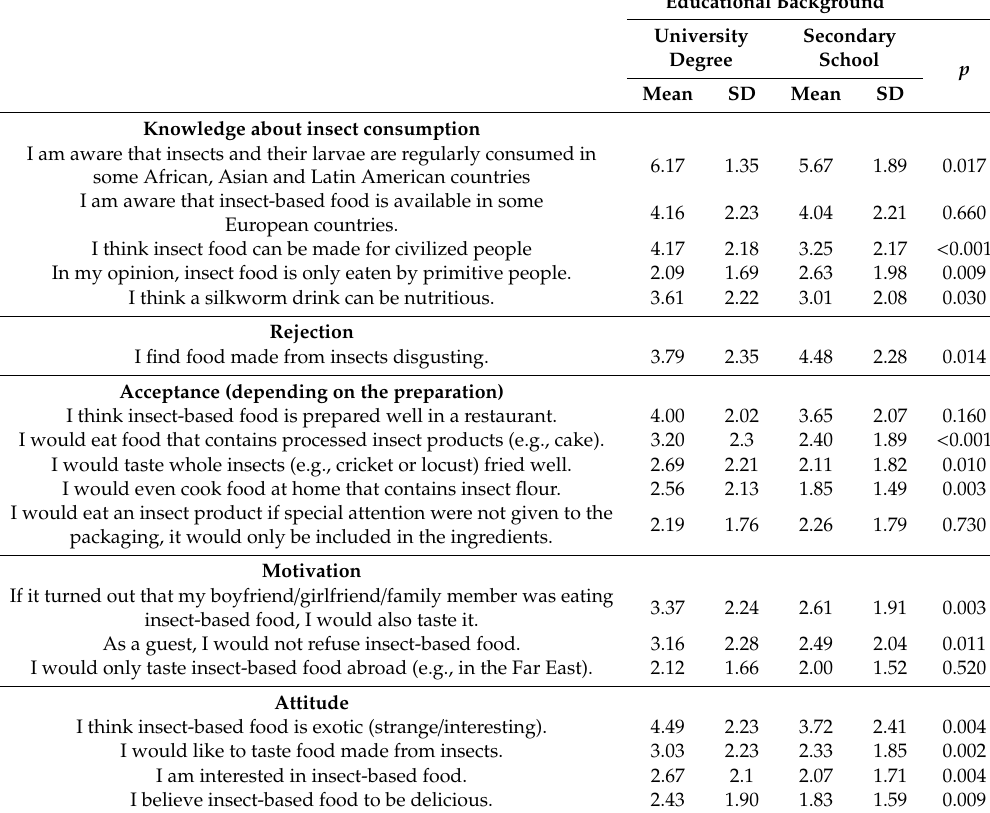
Table 4. E ff ect of educational background of respondents on opinions on insect-based food and its